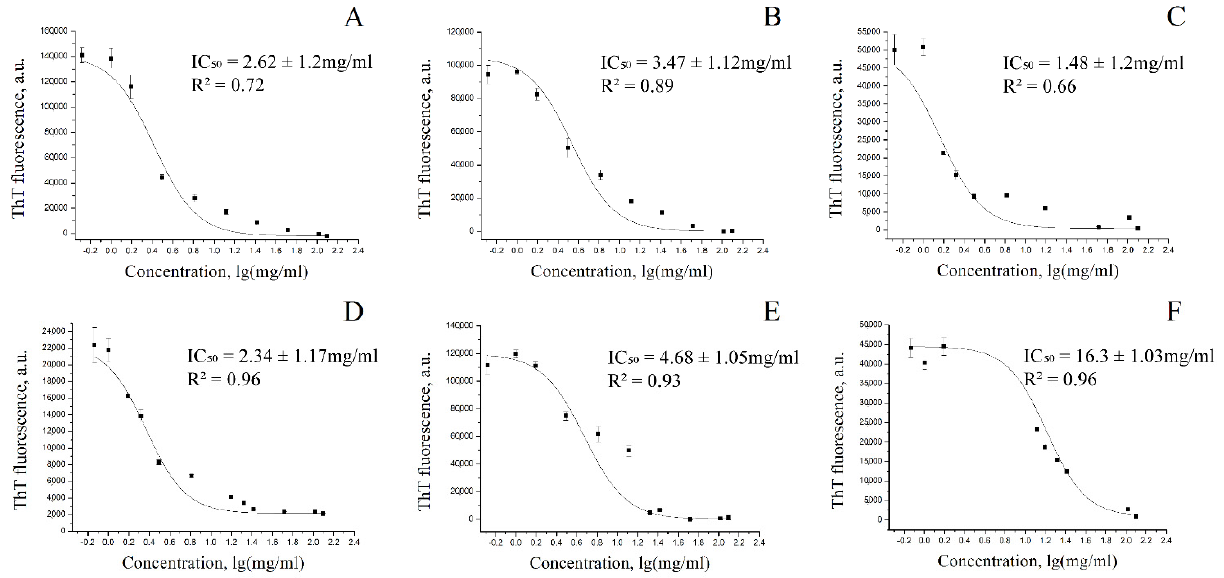
Figure 4. Inhibition of alpha-synuclein fibrillation by coffee extracts using thioflavin T fluorescence assay. ThT fluorescence intensity of aqueous extract of black coffee ( A ); aqueous extract of black coffee obtained by boiling ( B ); ethanol extract of black coffee ( C ); aqueous extract of green coffee ( D ); aqueous extract of green coffee obtained by boiling ( E ); and ethanol extract of green coffee ( F ). The fluorescence of thioflavin T was shown to drop with an increasing concentration of coffee extracts. Thus, the inhibitory effect of black and green coffee extracts on α -synuclein fibrillization is dose-dependent. The constants of half-maximal inhibition for aqueous extracts of black and green coffee were 2.62 mg/mL and 2.34 mg/mL, respectively; for aqueous extracts obtained by boiling, they were 3.47 mg/mL and 4.68 mg/mL for black and green coffee, respectively; and for 40% alcoholic extracts, they were 1.48 mg/mL (for black coffee) and 16.3 mg/mL (for green coffee). In a pairwise comparison, the constants of half-maximal inhibition of fibrillization for the green coffee extracts were comparable to or greater than those for black coffee. Since the main trends in the efficiency of alpha-synuclein fibrillization inhibition by black and green coffee extracts are opposite to the data on the ratio of the contents of the studied metabolites, except for ferulic acid, other by using